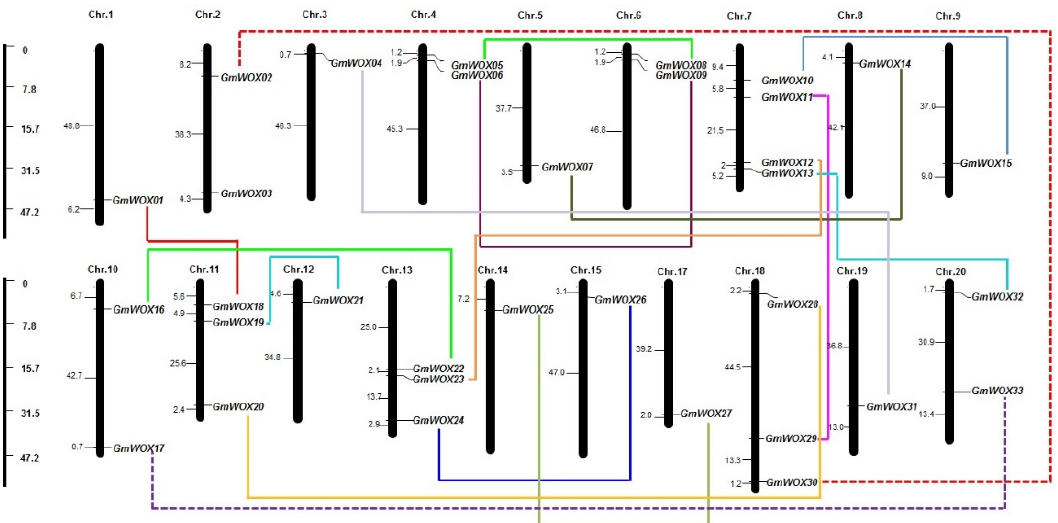
Figure 3. Chromosomal distribution and gene duplications of GmWOXs. The segmental duplicated genes are linked by lines. The scale bar on the left indicates the length (Mb) of soybean chromosomes.